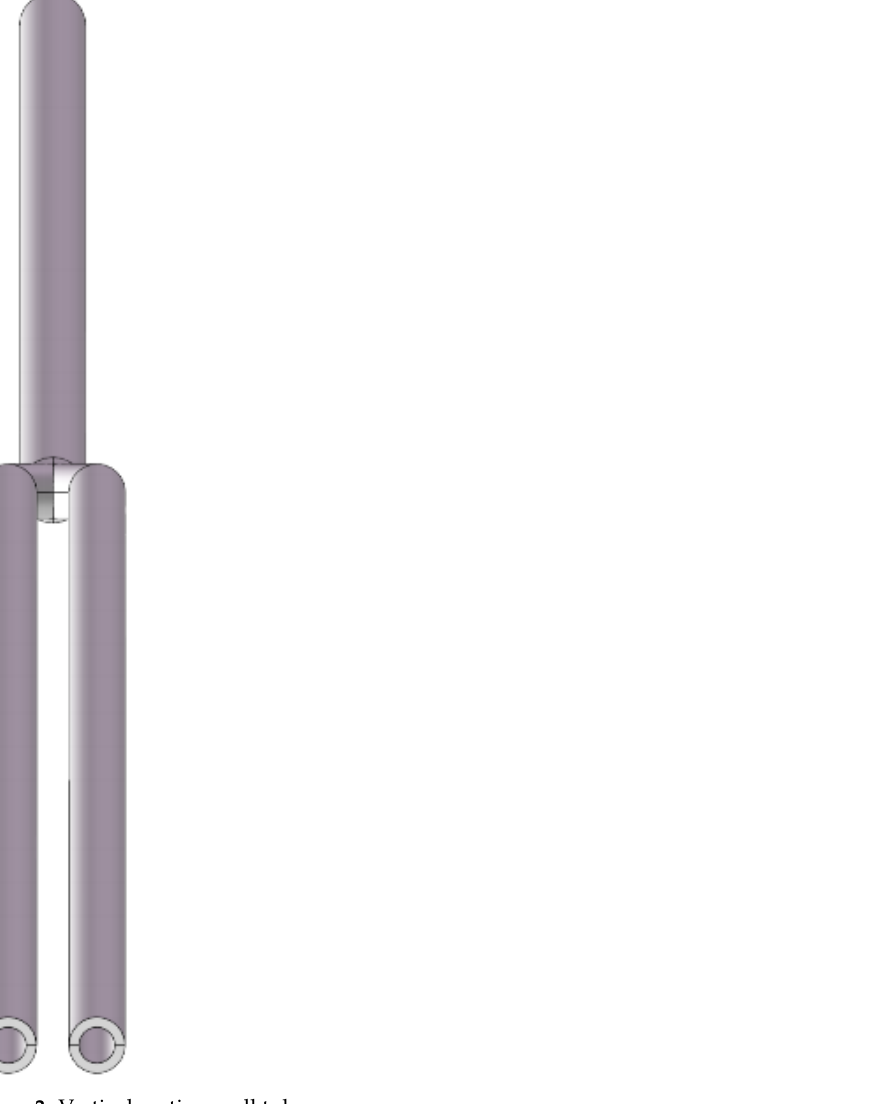
Figure 3. Vertical section wall tube.